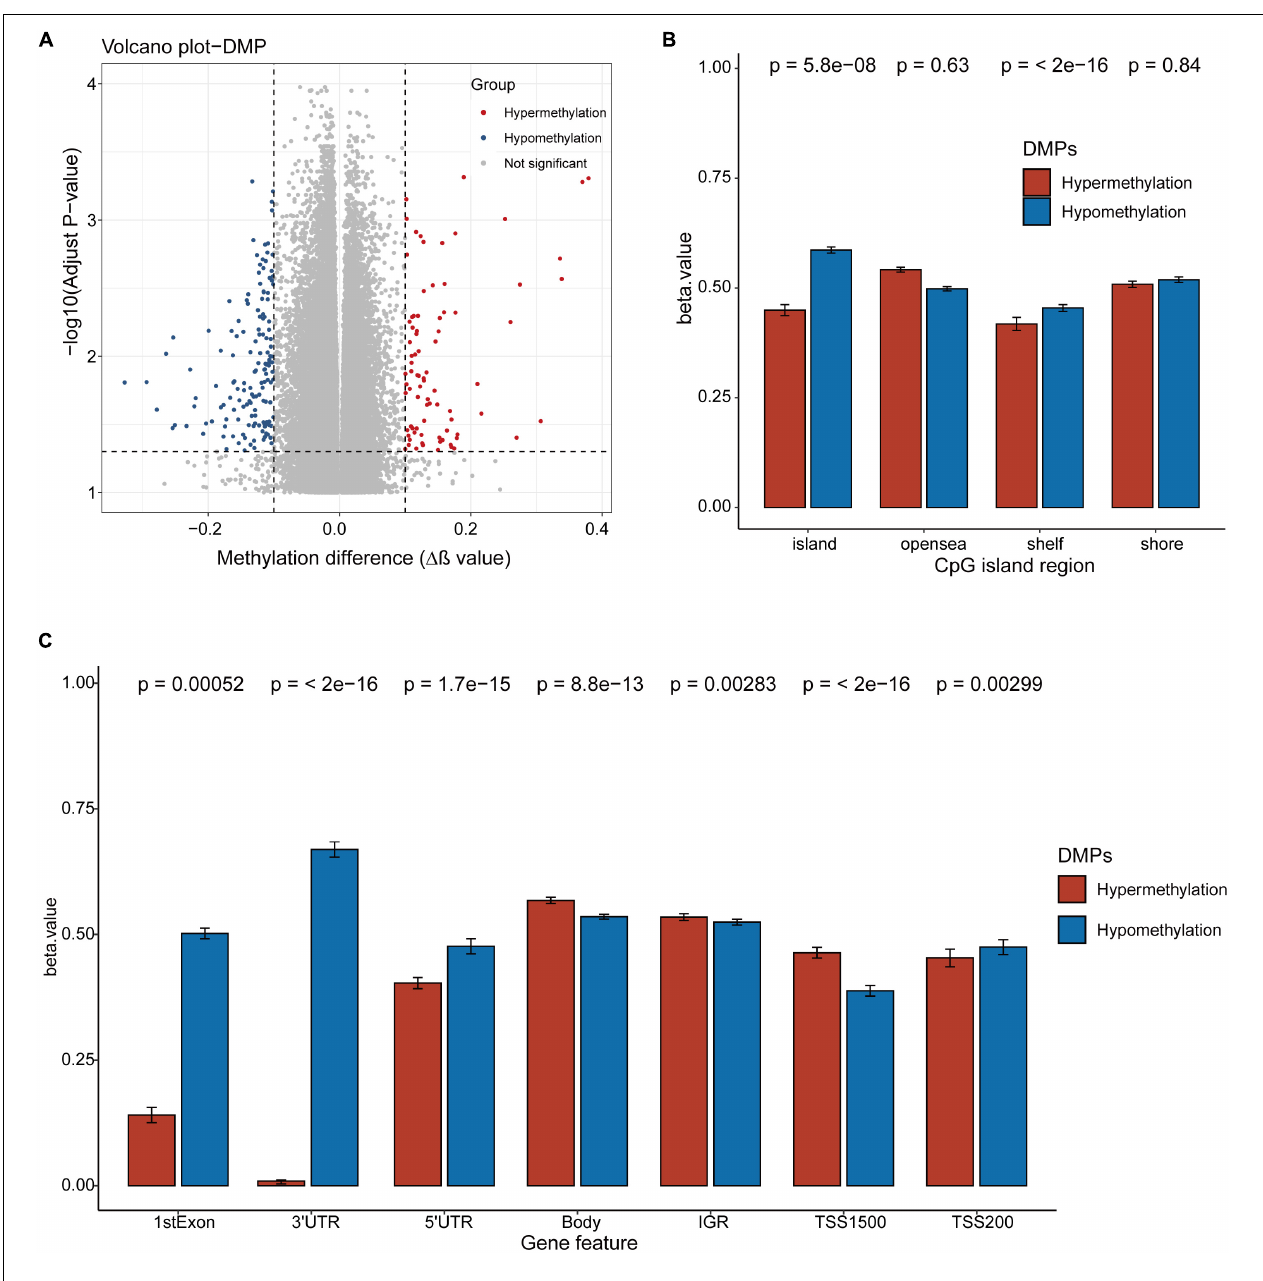
FIGURE 2 | Differentially methylated probes detected in the blood DNA of NAFLD patients with diagnosed liver fibrosis. (A) DNA methylation sites (probes) in the blood DNA of NAFLD patients with diagnosed liver fibrosis. Dots, DNA methylation probes. The cutoff values for differentially methylated probes (DMPs): adjusted p < 0.05 and | (cid:49) β | > 0.1. Red dots, hypermethylated DMPs; blue dots, hypomethylated DMPs. (B,C) The DMPs in CpG island regions (B) and gene regions (C) . hypermethylated DMPs (red), and hypomethylated DMPs (blue). P- values were calculated with the Chi-squared